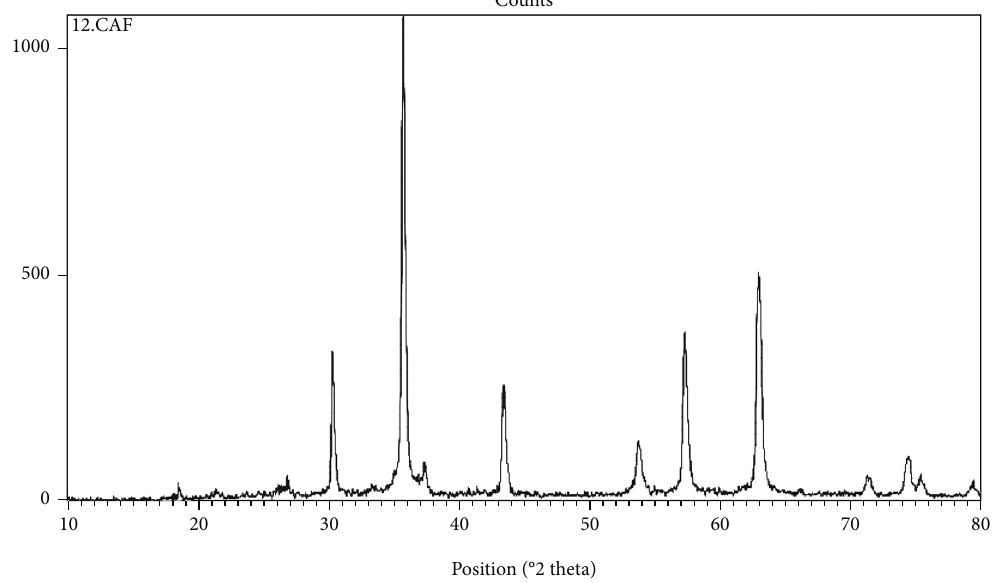
Figure 2: X-ray di ff raction spectrum of Fe